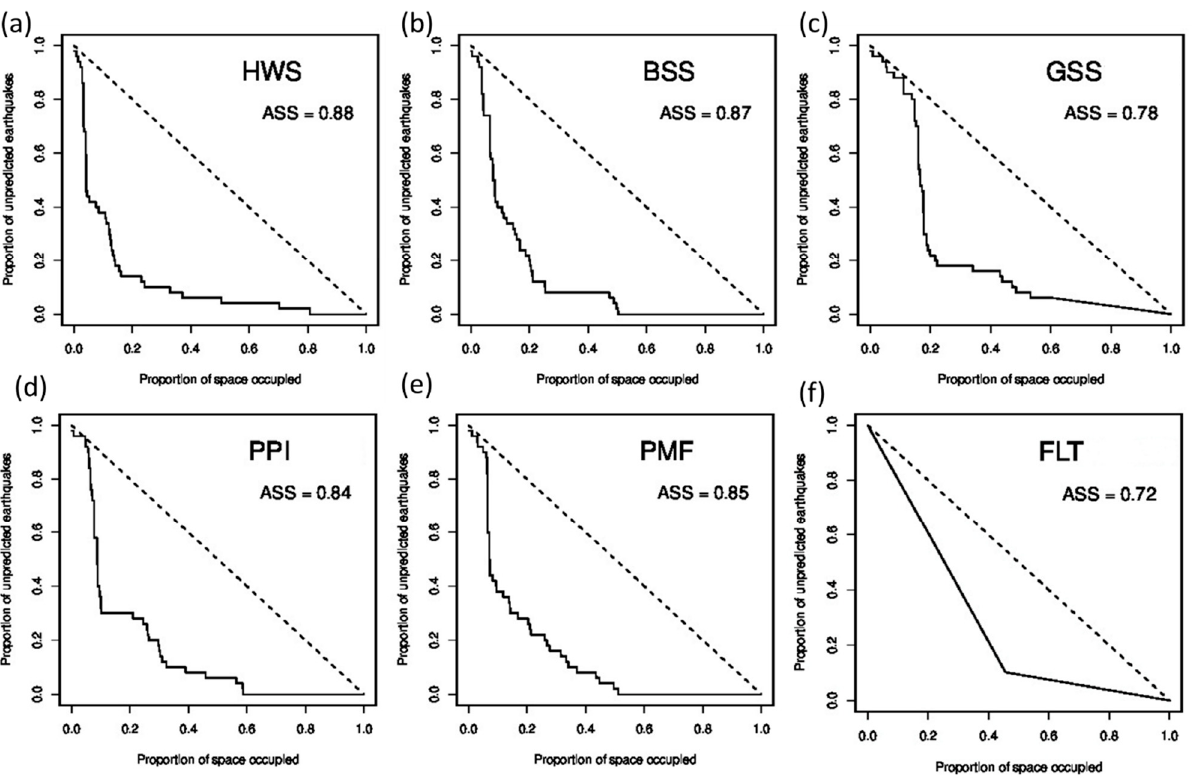
Figure 6. Molchan error diagrams for covariates ( a ) HWS, ( b ) BSS, ( c ) GSS, ( d ) PPI, ( e ) PMF, and ( f ) FLT, and target earthquakes in the forward test period 2012–2015.